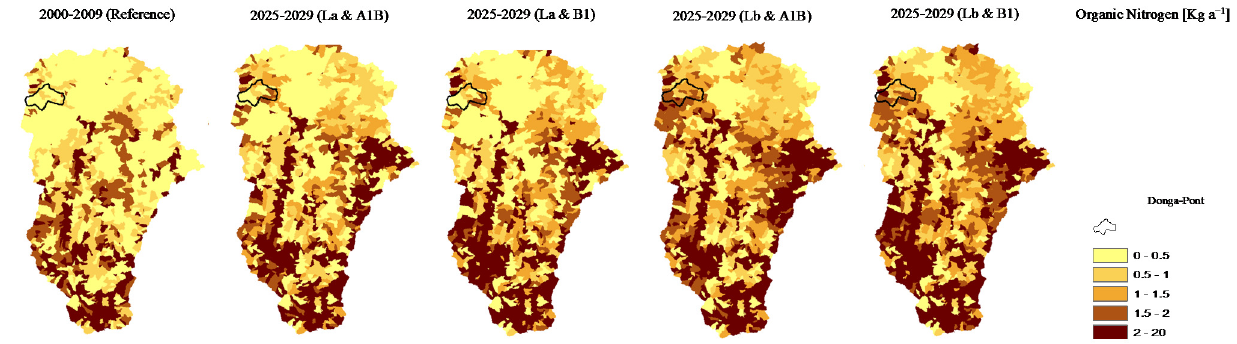
Figure 15. Impacts of land use and climate change on Organic Nitrogen patterns in the Ouémé-Bonou catchment (49,256 km 2